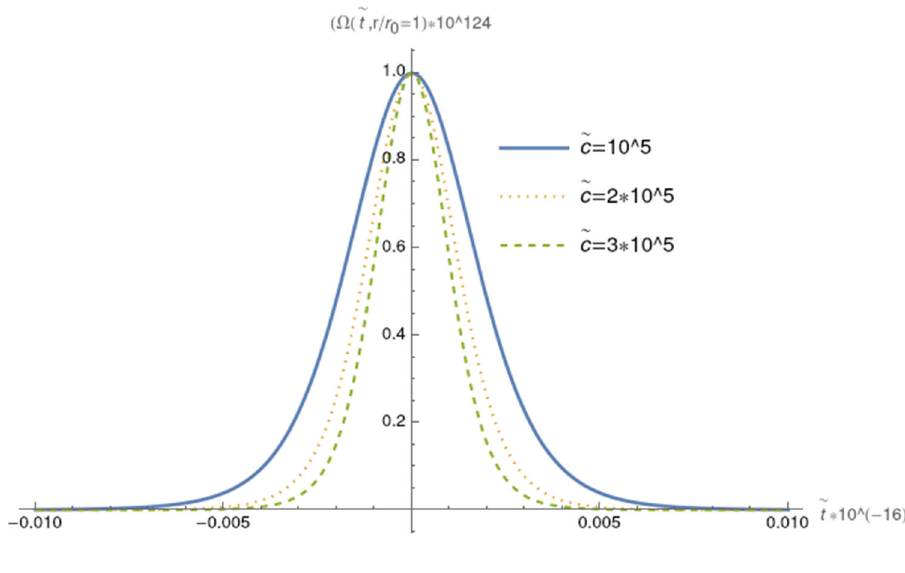
Fig. 2 Here we present the component (cid:9) + p r , divided by factor 10 124 , at the throat, r = r 0 = 10 − 2 / H 0 , for different values of the parameter ˜ c . We also assumed (cid:7)( r , t ) = 0, / r 2 , b ( r ) = r 3 0 S ( t ) = S ( t ) bounce , a min = 10 − 32 and the cosmological parameters (cid:9) 0 = 0 . 692, (cid:9) 0 = 0 . 308 v ac mat = 10 − and (cid:9) 0 rad